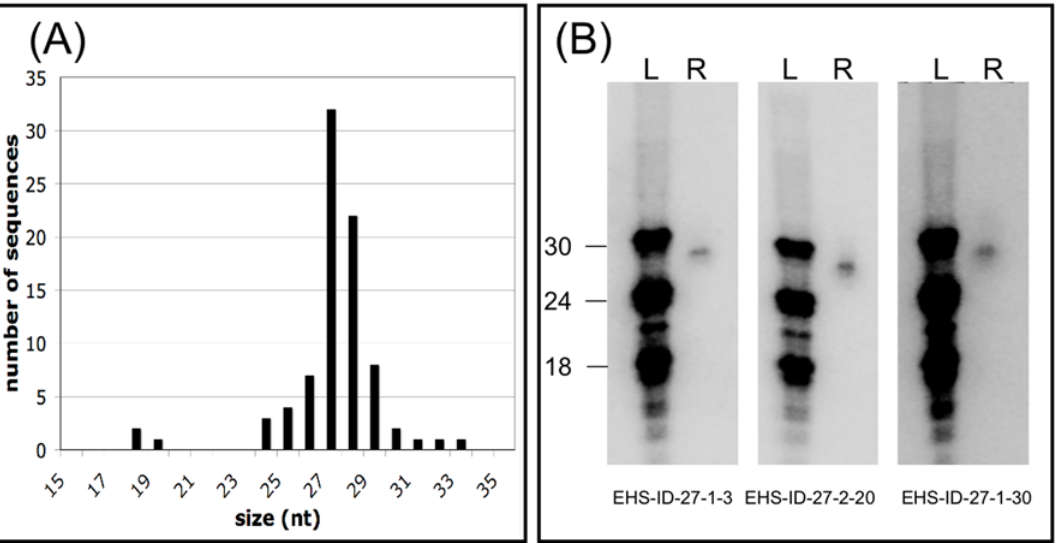
Figure 2. The 27 nt small RNAs can be cloned in a 5 9 P-independent manner. Using a 5 9 -phosphate independent cloning method the 27 nt RNA fraction was purified and small RNAs cloned and sequenced. (A) The size distribution of the cloned small RNAs. The number of cloned small RNAs is indicated on the y-axis and the size of the cloned RNAs is listed on the x-axis. (B) Cloned small RNAs can be detected at the appropriate size by Northern blot analysis. 10 m g of total RNA from E. histolytica trophozoites was probed with end-labeled 32 P oligonucleotides corresponding to the cloned small RNAs. L=ladder; R=RNA.